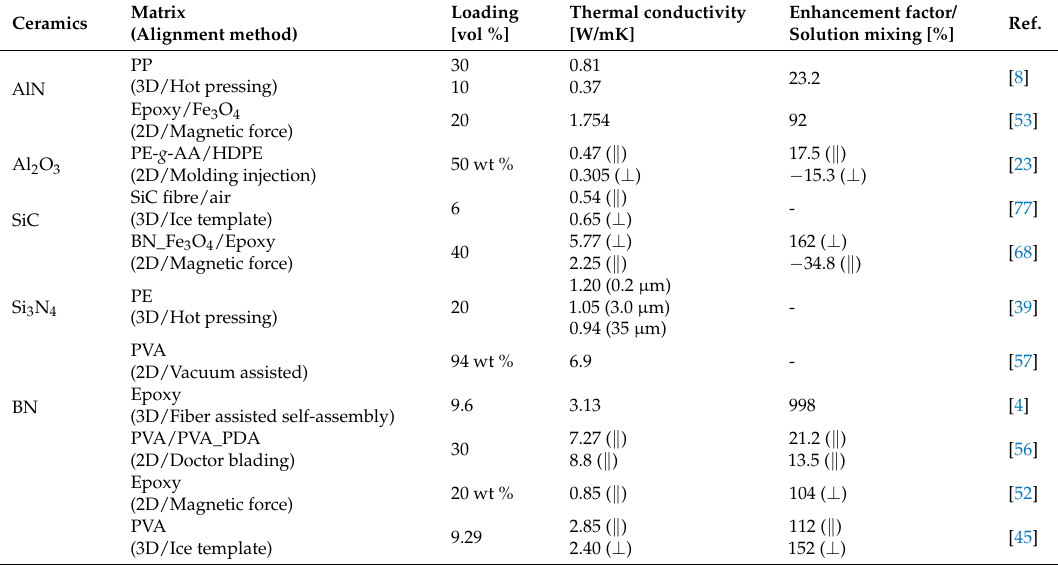
Table 2. Summary of thermal conductivity at room temperature and enhancement factor depending on the ceramics, the matrix, and the alignment method ( (cid:107) and ⊥ are values of the in-plane and through-plane directions,